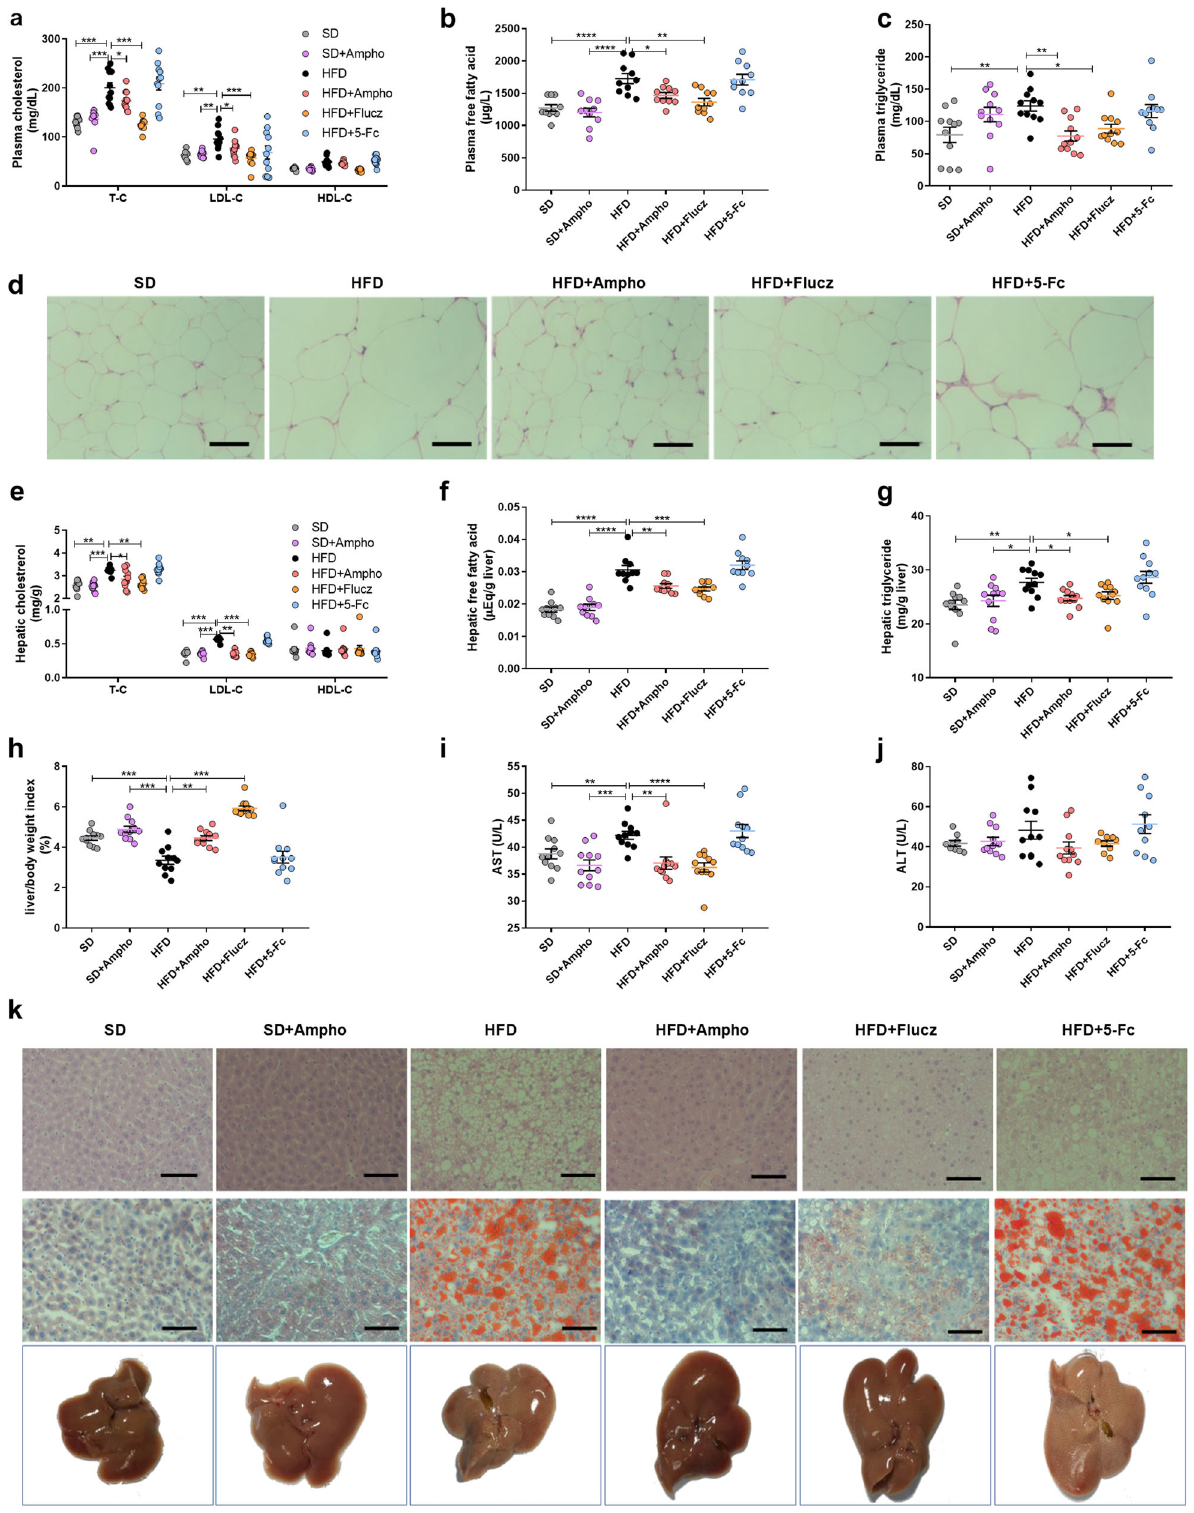
Fig. 2 Oral administration of Amphotericin B or fl uconazole alleviated obesity related disorders in HFD-fed mice. a Plasma cholesterol; b plasma free fatty acid; c plasma triglyceride; d representative H&E-stained pictures of adipose tissue; e hepatic cholesterol; f hepatic free fatty acid; g hepatic triglyceride; h liver/body weight index; i plasma aspartate transaminase (AST); j plasma alanine transaminase (ALT); k representative H&E staining, Oil Red O staining and macroscopic views of the liver. SD, stand diet-fed mice group; SD + Ampho, stand diet-fed mice treated with amphotericin B; HFD, high-fat diet fed mice group; HFD + Ampho, high-fat diet fed mice treated with amphotericin B; HFD + Flucz, high-fat diet fed mice treated with fl uconazole; HFD + 5-Fc, high-fat diet fed mice treated with 5- fl uorocytosine. Data are presented as mean ± SEM. N = 10 − 11 mice per group. Statistical analysis was performed using one-way ANOVA followed by the Tukey post hoc test for ( a − c ), ( e − j ). * p < 0.05; ** p < 0.01; *** p < 0.001; **** p < 0.0001.